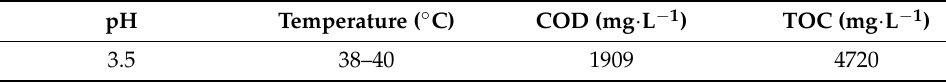
Table 4. Properties of industrial wastewater sample.